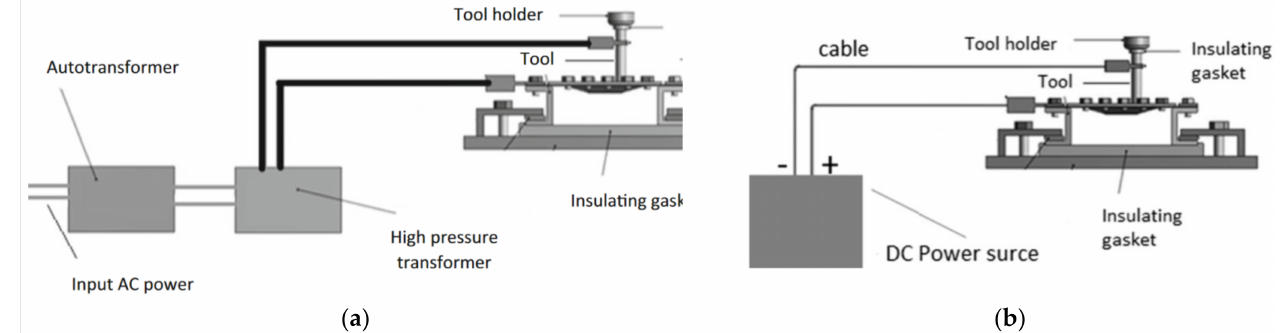
Figure 11. Schematic diagram of the E-ISF process with ( a ) AC and ( b ) DC power (reprinted with permission from [102]; copyright © 2016, Springer-Verlag